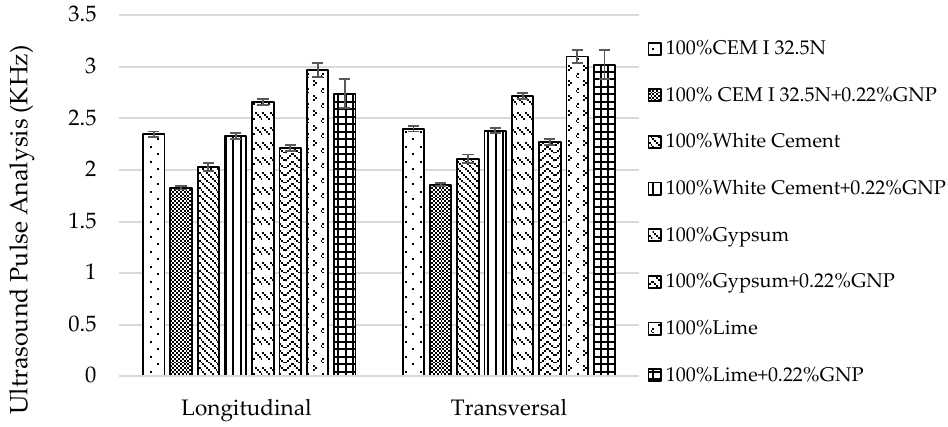
Figure 5. Changes in the UPA of various mortars and the binder type, binder percent, supplement type, and supplement